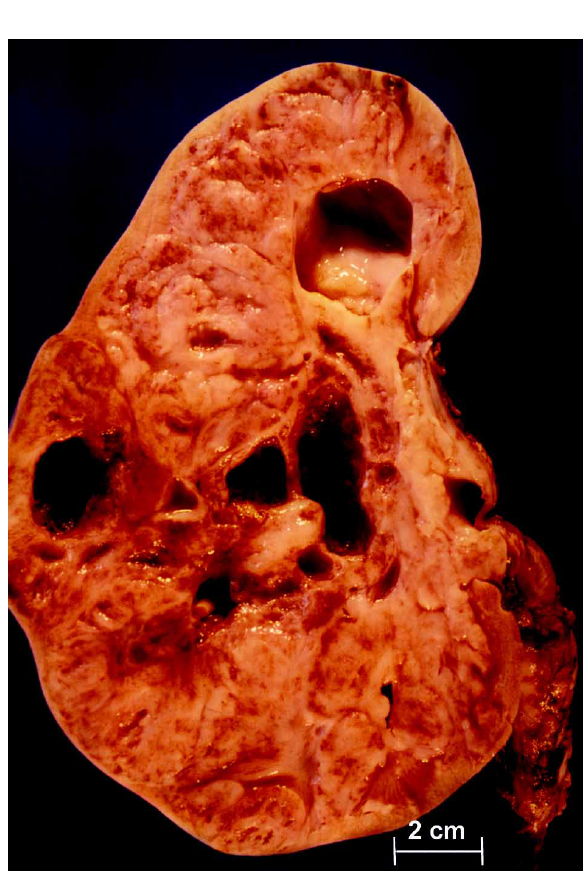
Figure 2 - Macroscopic view of the